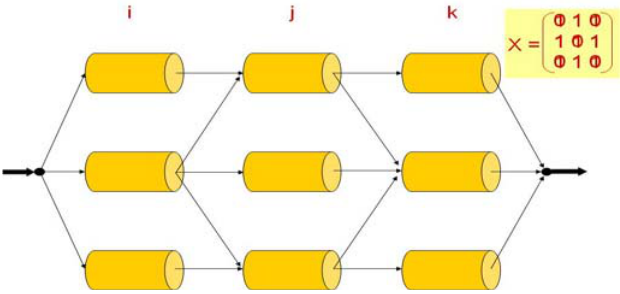
Figure 3. Superstructure connection variables.